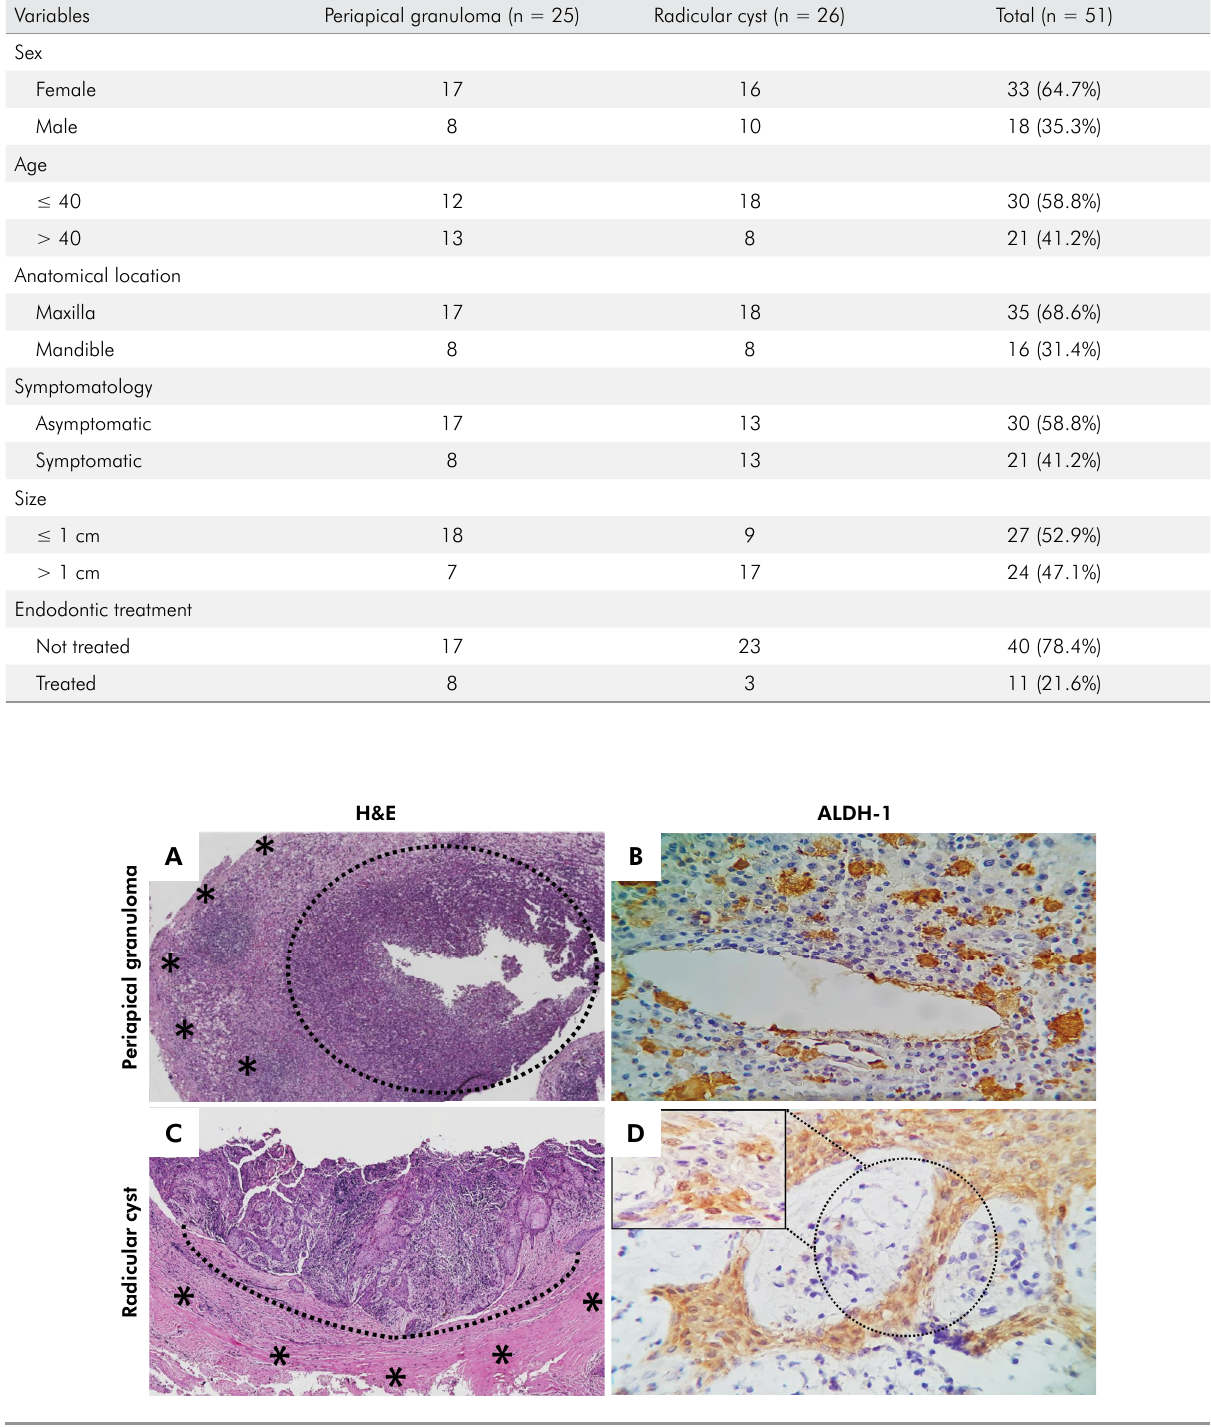
Figure 1. Photomicrograph of a periapical granuloma and radicular cyst. (A) Granuloma capsule (asterisks) and central region of the lesion (dashed circle). (C) Periapical cyst exhibiting a cystic capsule (asterisks) and arciform epithelial lining (above the dashed line). Cytoplasmic immunoexpression of ALDH-1 in the periapical granuloma and radicular cyst. (B) Diffuse cytoplasmic immunostaining in cells of the center of a periapical granuloma. (D) Diffuse immunostaining of epithelial cells of the periapical cyst (A, C: H&E, ×20; B, D: IHC,